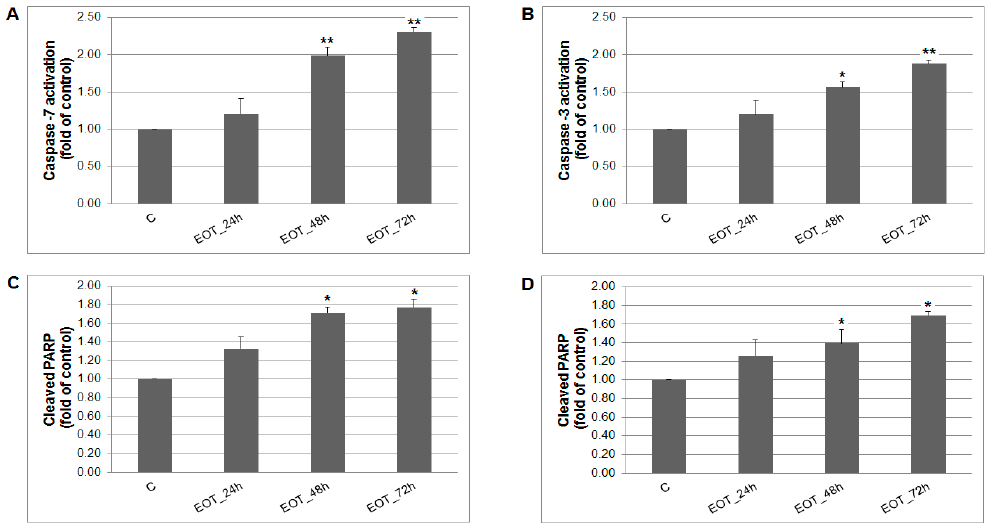
Figure 9. The effect of EOT treatment (0.13 or 0.12 µg/mL) on: ( A ) caspase-7 (MCF-7), ( B ) caspase-3 activation (MDA-MB-231), and PARP cleavage in both cell lines ( C , D ) analyzed by flow cytometry. Data were obtained from three independent experiments and significant differences are shown: * p < 0.05, ** p < 0.01 versus control cells (untreated).